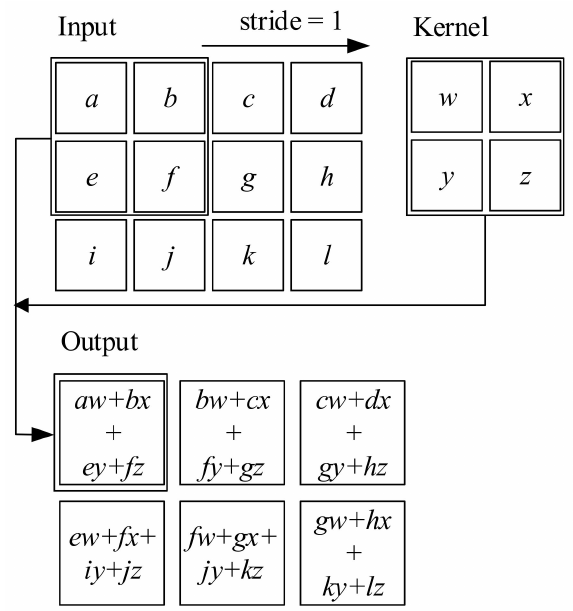
Figure 1. Convolution in a convolutional